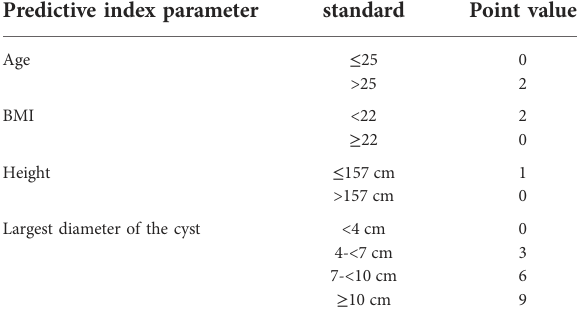
TABLE 4 Final score of predictive index parameters, including 4 features. Predictive index parameter